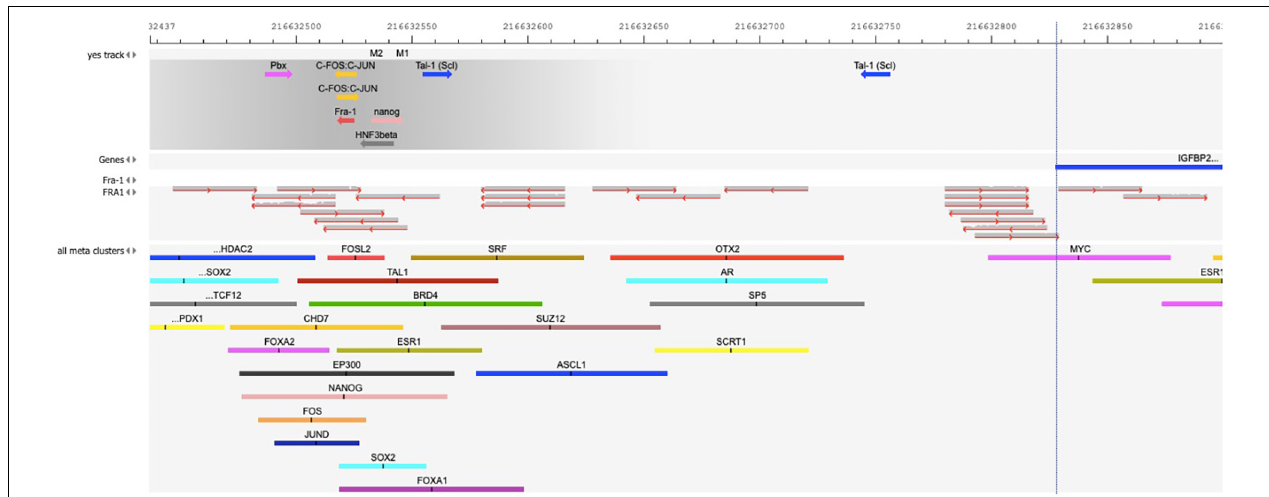
FIGURE 2 | Map of the cluster of transcription factor (TF) binding sites of the composite model identified within the promoter of IGFBP2 gene [–1000 to + 100 bp relative to TSS]. The position of the TSS (the beginning of the first exon on IGFBP2 gene) is shown by the vertical dotted line. “Yes track” represents the cluster of identified TF binding sites of the composite model within the promoter. The direction of the arrows gives the orientation of the PWMs. The names of TFs binding to these sites are shown above the arrows. The track “FRA1” represents the mapped reads of the FRA1 (also called FOSL1) ChIP-seq data of GEO, GSM803382. The reads were mapped on the hg38 human genome using Subread aligner (Liao et al., 2013) with default parameters. The track “all meta clusters” shows all known meta-clusters in this region from the GTRD database that represent the overlapping fragments of peaks for one particular TF from several ChIP-seq experiments. The name of TF is shown above each meta-cluster. Several predicted TF binding sites in the composite model are confirmed in independent ChIP-seq experiments: several overlapping reads of FRA1 ChIP-seq data in the “FRA1” track and FOSL2 meta-cluster in the GTRD confirm the predicted site for Fra-1; FOS and JUN meta-clusters in the GTRD confirm the predicted c-Fos/c-Jun binding sites; NANOG meta-cluster confirms the predicted Nanog binding site; TAL1 meta-cluster confirms the predicted Tal-1 binding site; FOXA2 and FOXA1 meta-clusters of the GTRD confirm the HNF3beta binding site.